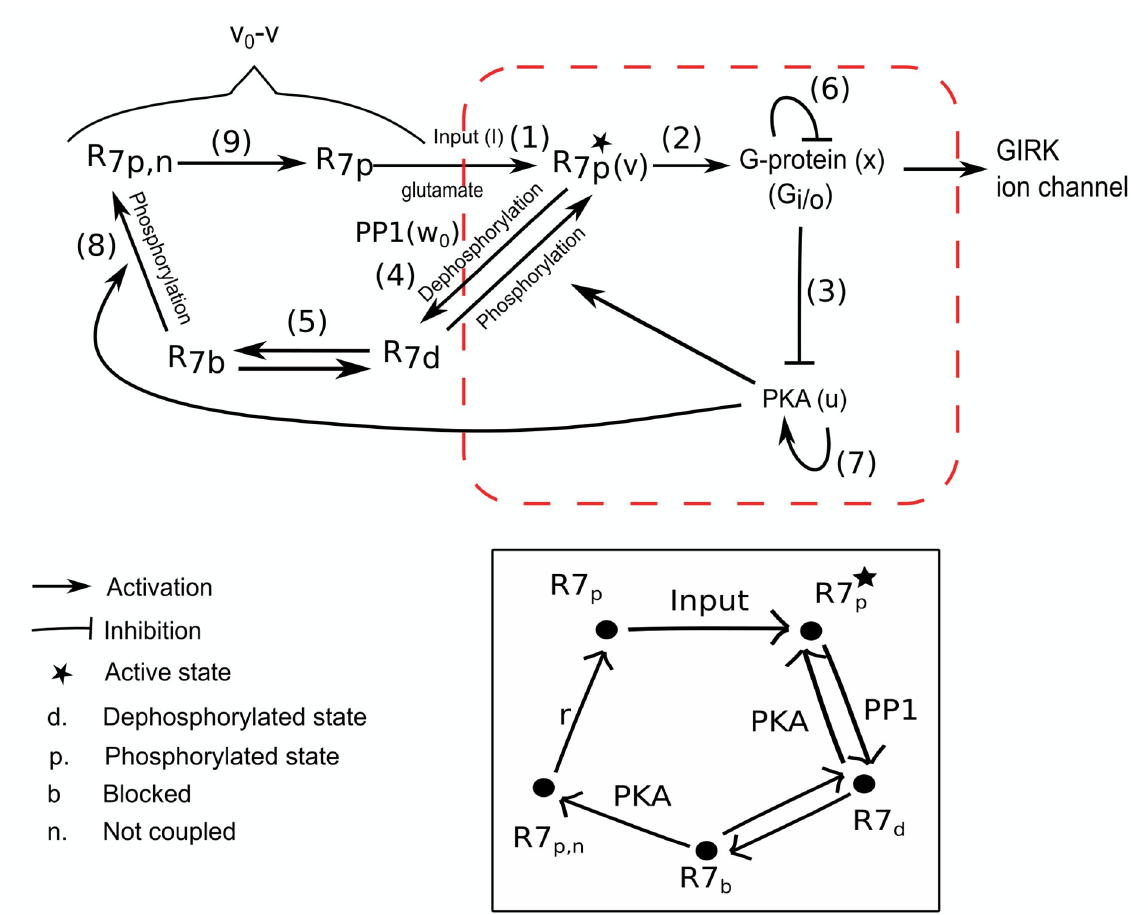
Fig 2. Interactions between different biochemicals involved in our proposed mechanism of the conditional response in the Purkinje cell. Abbreviations: R7—mGLuR 7 receptor, PKA—Protein Kinase A, PP1—Protein Phosphatase 1, GIRK—G-protein coupled Inward Rectifier Potassium ion channel. The numbers on the top of the arrows highlight the order in which the different reactions occur during the conditional response. Conditional response initiates with the release of glutamate from parallel fibers denoted by I as input in (1), which activates mGluR 7 receptors. In (2), active receptors activate G-proteins, which deactivate PKA through (3). As PKA activity reduces, PP1 activity becomes dominant (4) causing dephosphorylation of the receptor. The dephosphorylated receptor will be blocked by Arrestin protein to prevent further signaling transduction and also decouples the receptor from the protein complex (5). As receptor activity reduces, RGS8 reduces G-protein activity (6), which allows PKA activity to rise again (7). Active PKA will phosphorylate dephosphorylated receptors (8) to prevent their rapid internalization and the uncoupled phosphorylated receptor will couple back to the protein complex (9) for another conditional response. The red box identifies the three variables and their interactions used in the minimal mathematical model to capture the conditional response behaviour. Here, u , v and x represent the activities of PKA, mGluR 7 receptor and G-protein, respectively. These protein interactions occur in each individual TEC unit present at the synapse. The remaining states of the mGluR 7 receptor are collectively denoted as v 0 − v , where v 0 is the maximum possible activity of the mGluR 7 receptor. Below, in the black box we highlight the pictorial description of the 5-state model of mGluR 7 receptors, which is explicitly used in the comprehensive mathematical model. means that each GIRK ion channel forms a protein complex with four units of each of G-pro- teins, receptors and RGS8 proteins along with PKA and PP1 proteins together with their anchoring proteins. As each of these protein complexes has their own intrinsic dynamics, which regulate how fast the GIRK ion channel opens and closes upon stimulation, we can call each of these protein complexes “Time-Encoding protein Complexes” (TEC). Within each TEC, the rate of G-protein activation by the receptor and the rate of binding of G-protein sub- units to the GIRK ion channel decide the overall rate of opening of GIRK ion channels i.e., the